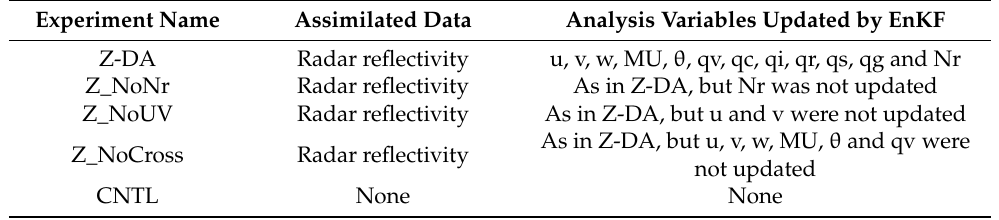
Figure 2. Workflow of the CNTL and the reflectivity DA experiments. Table 1. List of